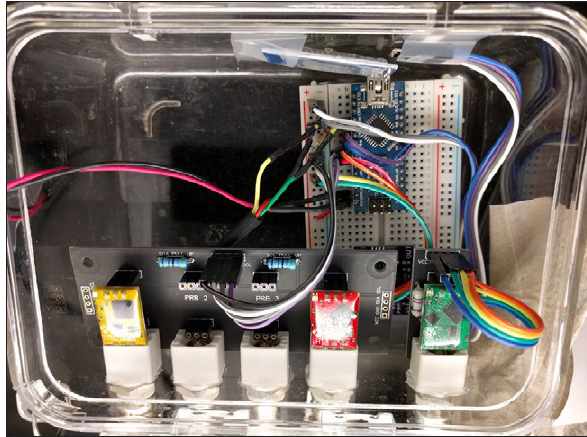
Figure 2: Close-up of the prototype array showing com- ponents. Photo by Eric